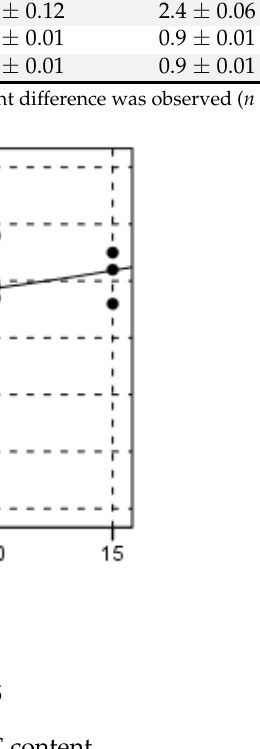
Figure 1. Growth performance parameters with dietary RPC levels.